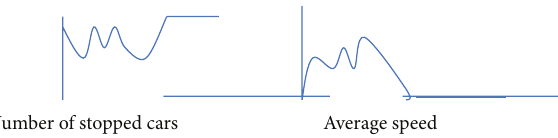
Figure 2: Gridlock graphs projected in real time in upfront